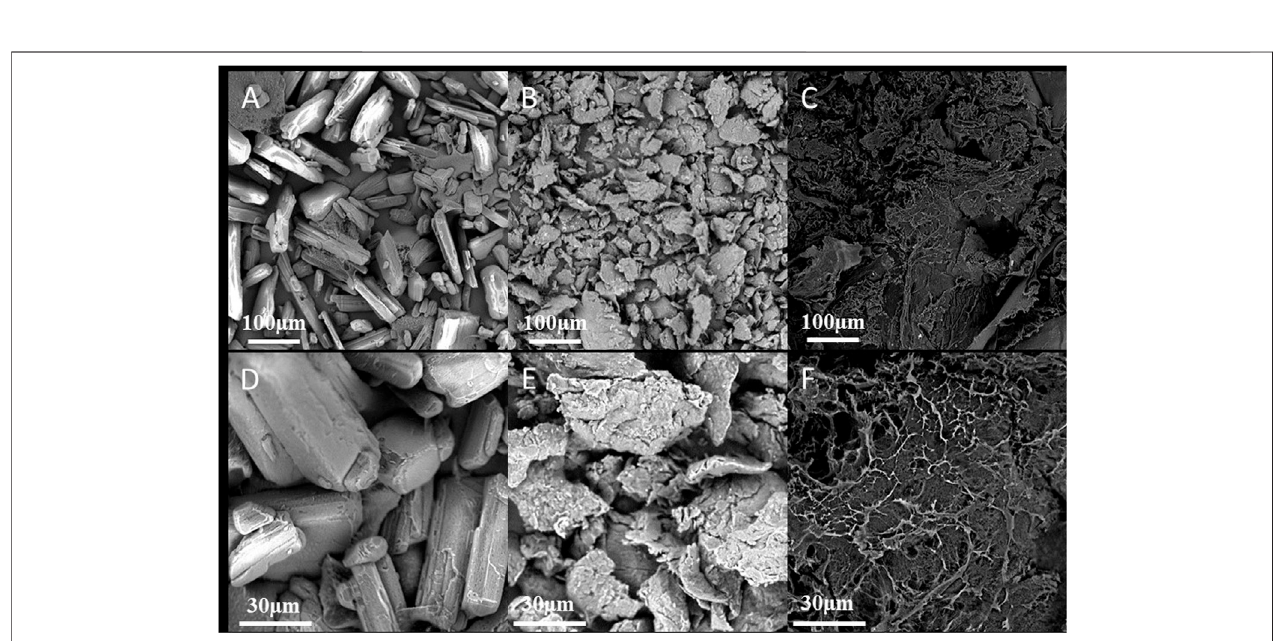
FIGURE 2 | FE-SEM images of pure ibuprofen (A, D) , chitosan powder (B, E) , and chitosan – ibuprofen aerogels (C, F) .